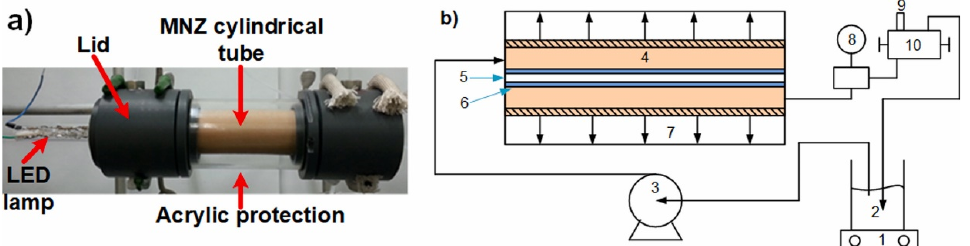
Figure 2. ( a ) Membrane module, ( b ) reaction system schematic diagram: (1) magnetic stirrer, (2) feed solution, (3) diaphragm pump, (4) MNZ cylindrical membrane, (5) lamp, (6) quartz tube, (7) acrylic tube, (8) pressure gauge, (9) sampling, (10) valve [58].